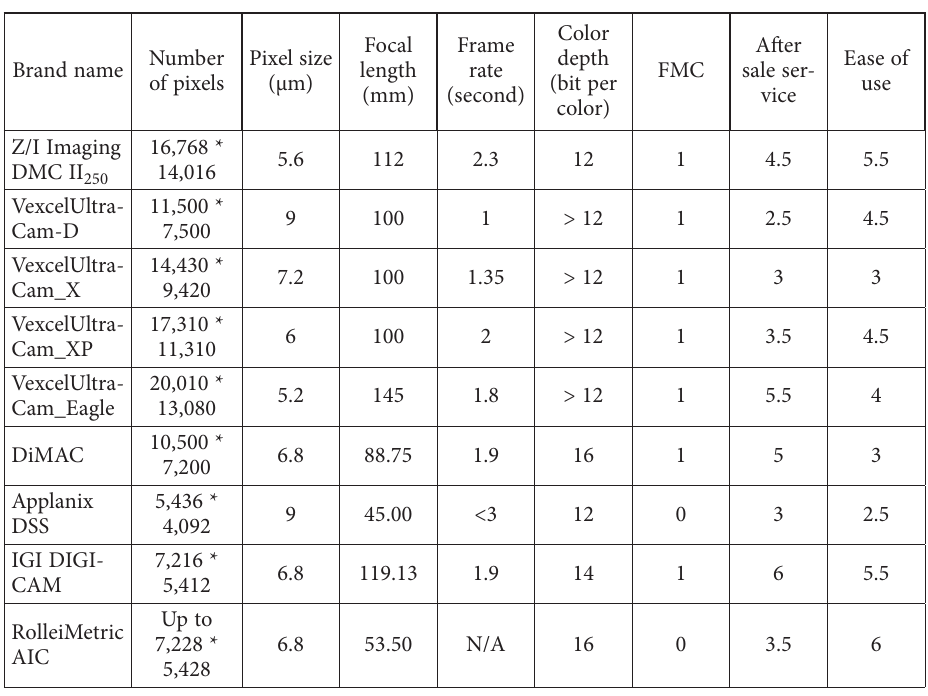
Table 7. Score function decision matrix of camera selection